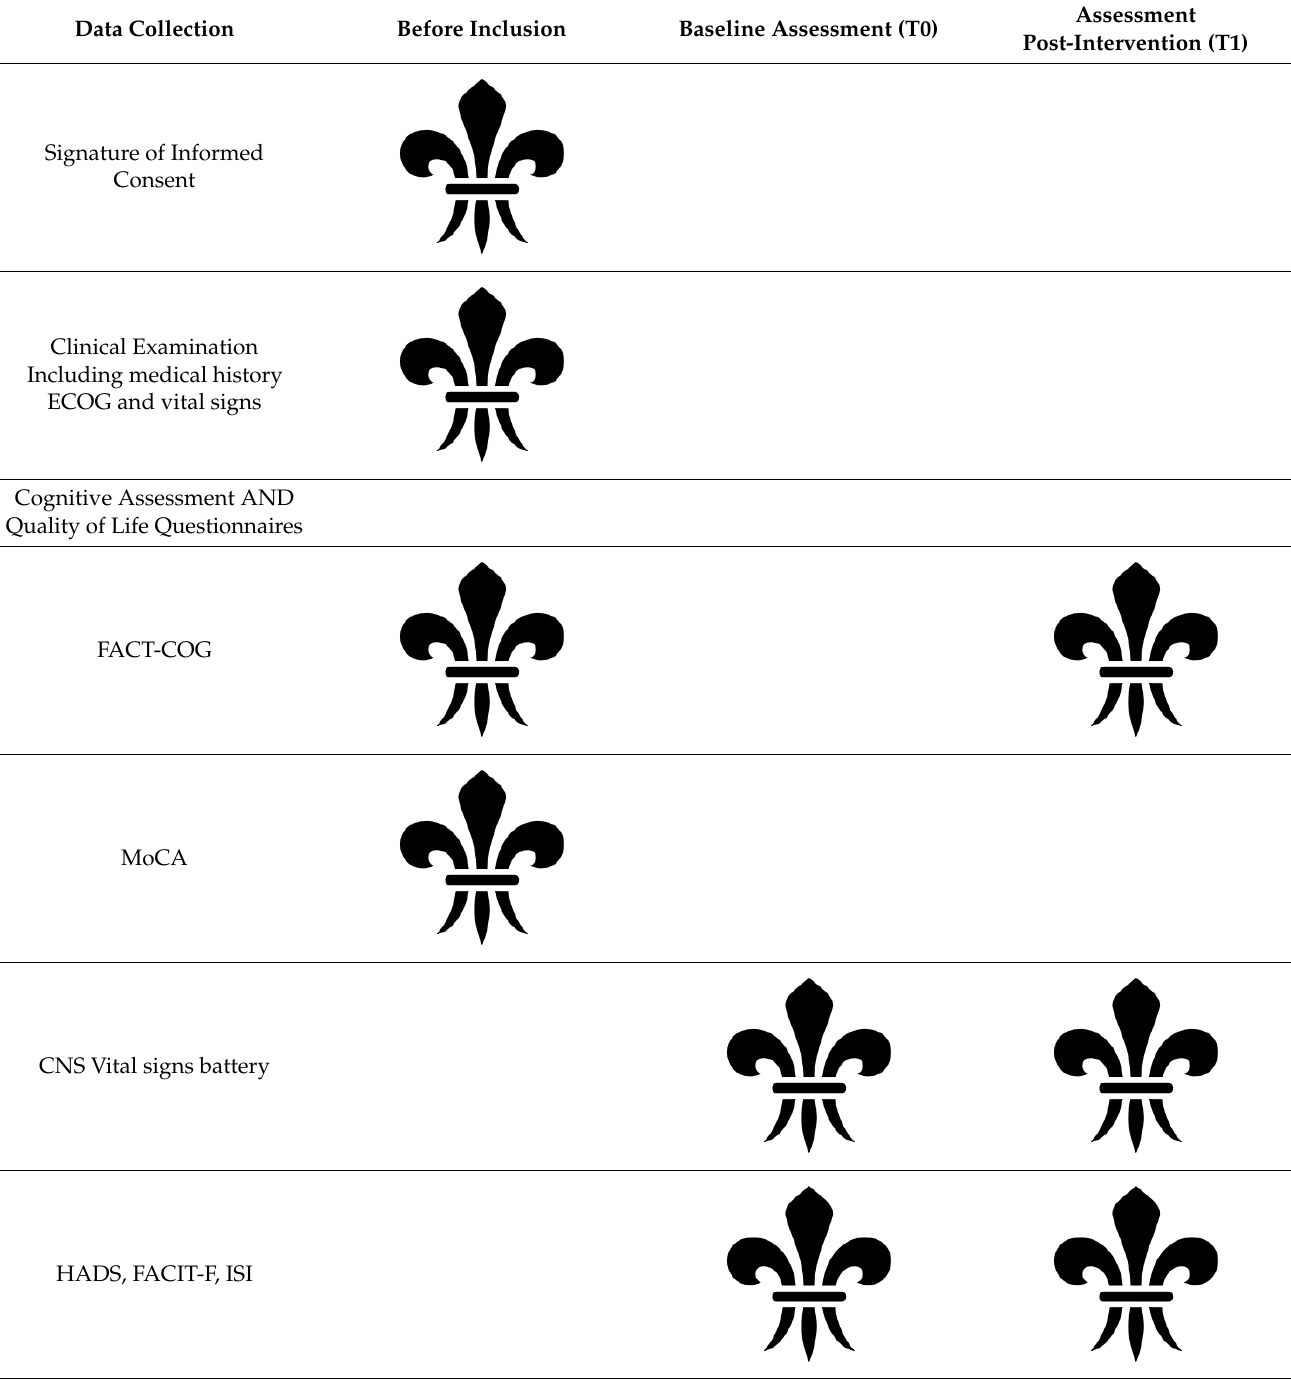
Table 1. Details concerning data collection.